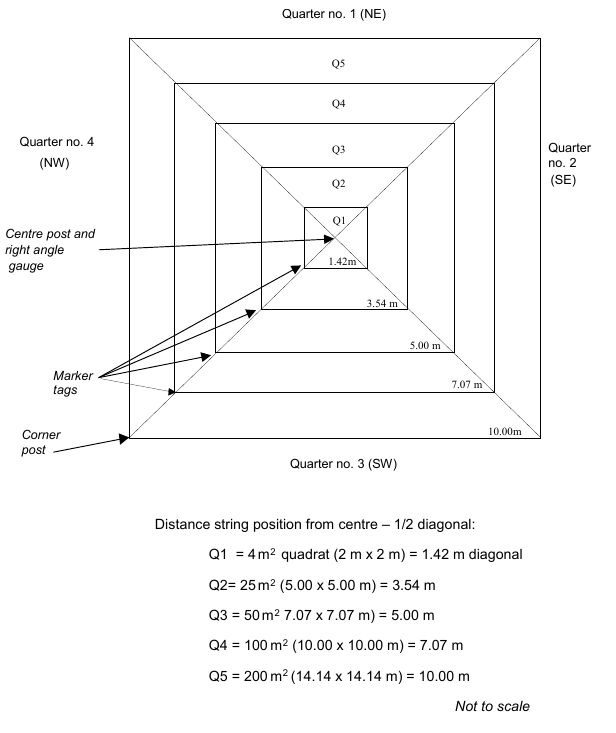
Figure 4. Layout of vegetation X